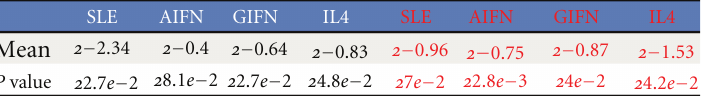
Figure 5: SLE is known to be associated with increased expression of interferon-inducible genes and these genes have a strong association of H4ac and gene expression. We noted another cluster had a similarly strong association of H4ac and gene expression. The chemokine cluster was identified as having significantly decreased expression and H4ac in SLE monocytes. (a) The heatmap demonstrating the association of gene expression and H4ac. (b) The statistical relationship between the